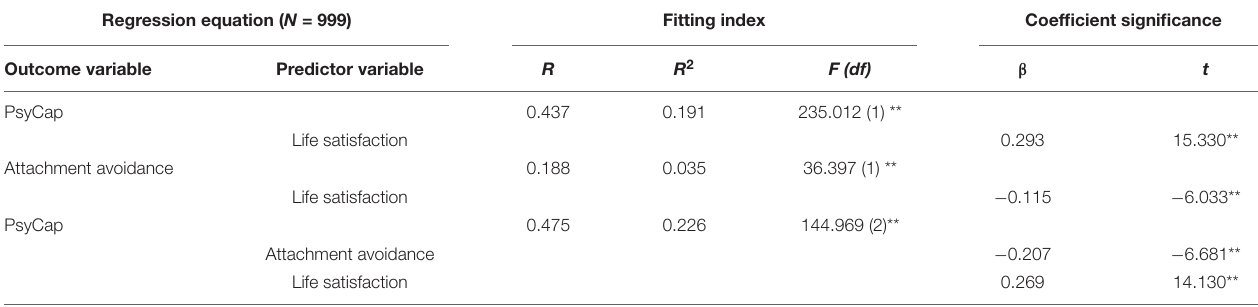
TABLE 2 | The mediation model of attachment avoidance.